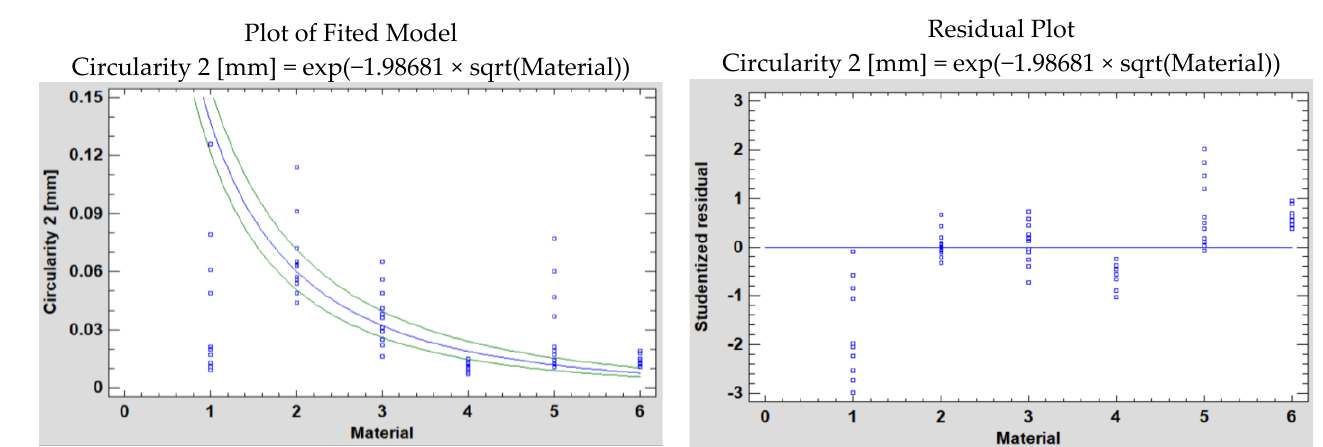
Figure 7. Plot of fitted model and residual for circularity 2.